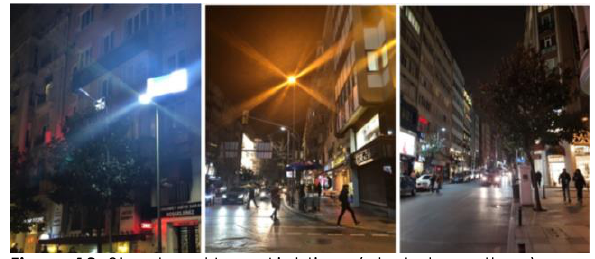
Figure 10. Street and Lane Lightings (photo by authors)